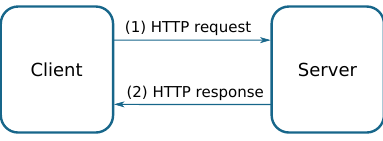
Figure 3. Basic RESTful architecture.